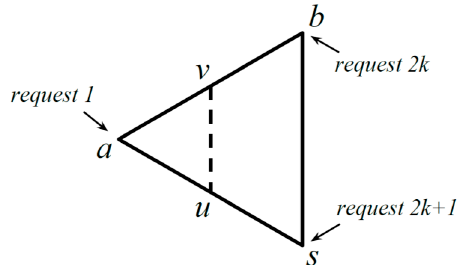
Figure 1. The request sequence a , b , s , b , s , b , s , . . . to access the page at the server; k